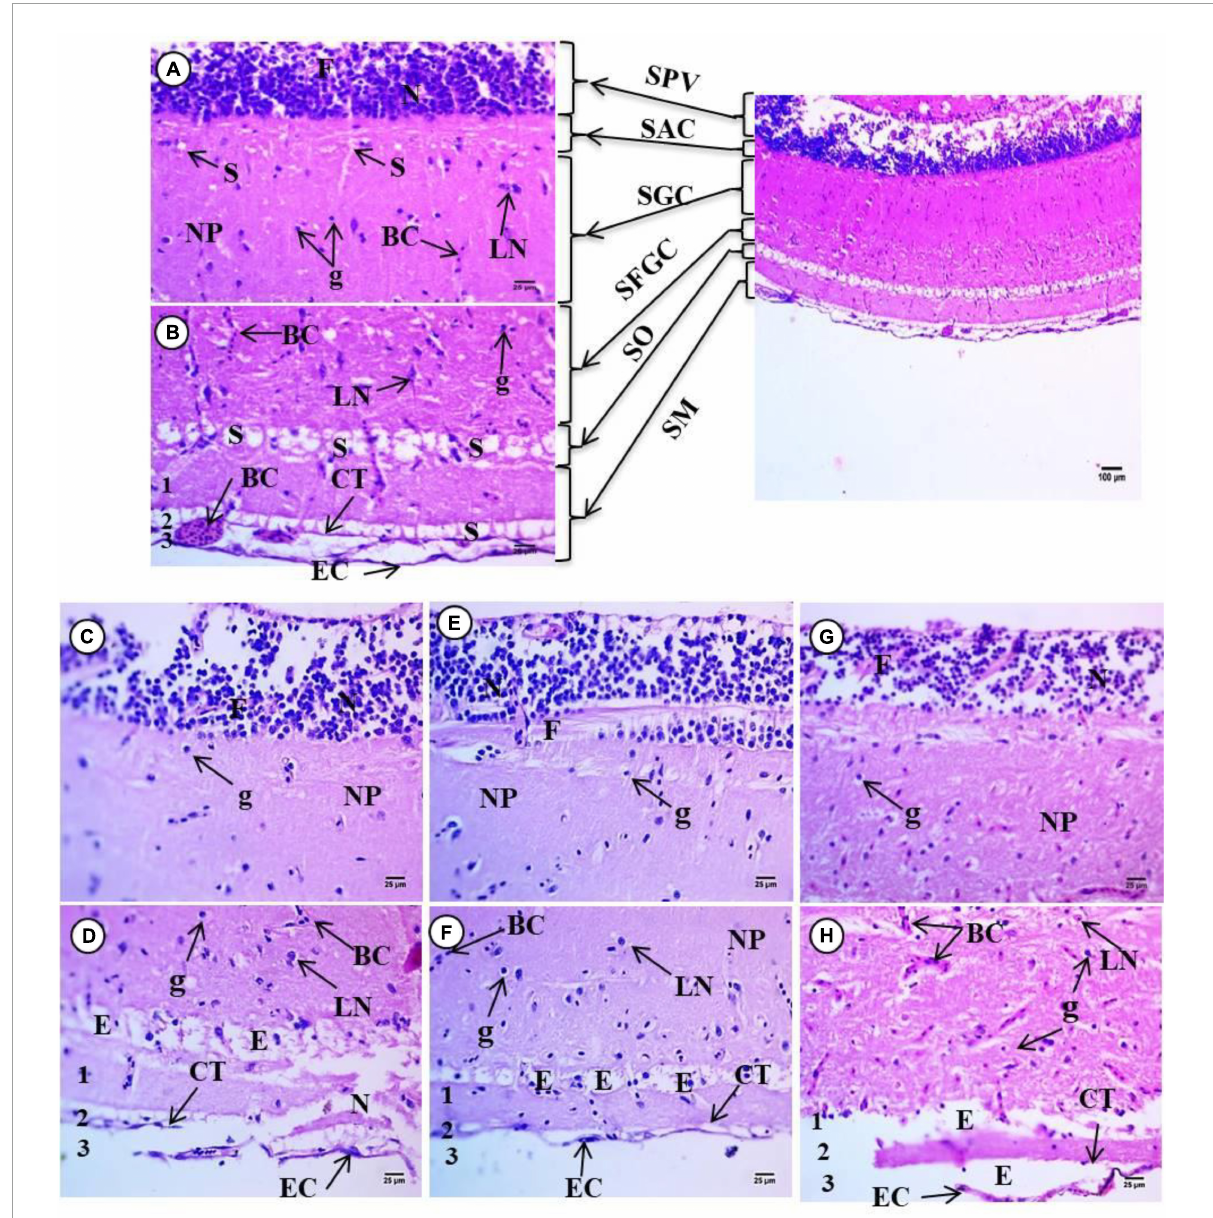
FIGURE1 Representative sections of optic tectum of control and treated fish Cyprinus carpio ; (A,B) sections of control fish brain showing Optic tectum of Carp intact zones, Stratum periventriculare (SPV) in the inner region, album centrale (SAC), followed by griseum centrale (SGC), fibrosum et grisium superficiale (SFGS), opticum (SO), and marginale (SM). (C,D) Exposure to 100 mg/L of macroplastic for 15 days showing necrosis (N) and fibrosis (F) in the granular cells of the SPV zone, spongiosis/edema (E) of granular cells of the SFGC zone and degenerated connective tissues (CT) and degenerated outer squamous cells (EC); (E,F) exposure to 100 mg/L of microplastic for 15 days showing detachment and high degeneration of large neuronal cells (LN) and glial ganglion cells (g) of the SFGS, edeama (E) of granular cells of the OS zone and degenerated connective tissues (CT) and outer squamous cells (EC). (G,H) Exposure to 100 mg/L of nanoplastic for 15 days showing necrosis (N) and fibrosis (F) in SPV zone, increase in blood capillaries (BC), detachment and necrosis in large neurons (LN) and ganglion cells (g) in the SFGS zone, edema in SO zone and degenerated connective tissues (CT) and outer squamous cells (EC) (H&E × 400) .